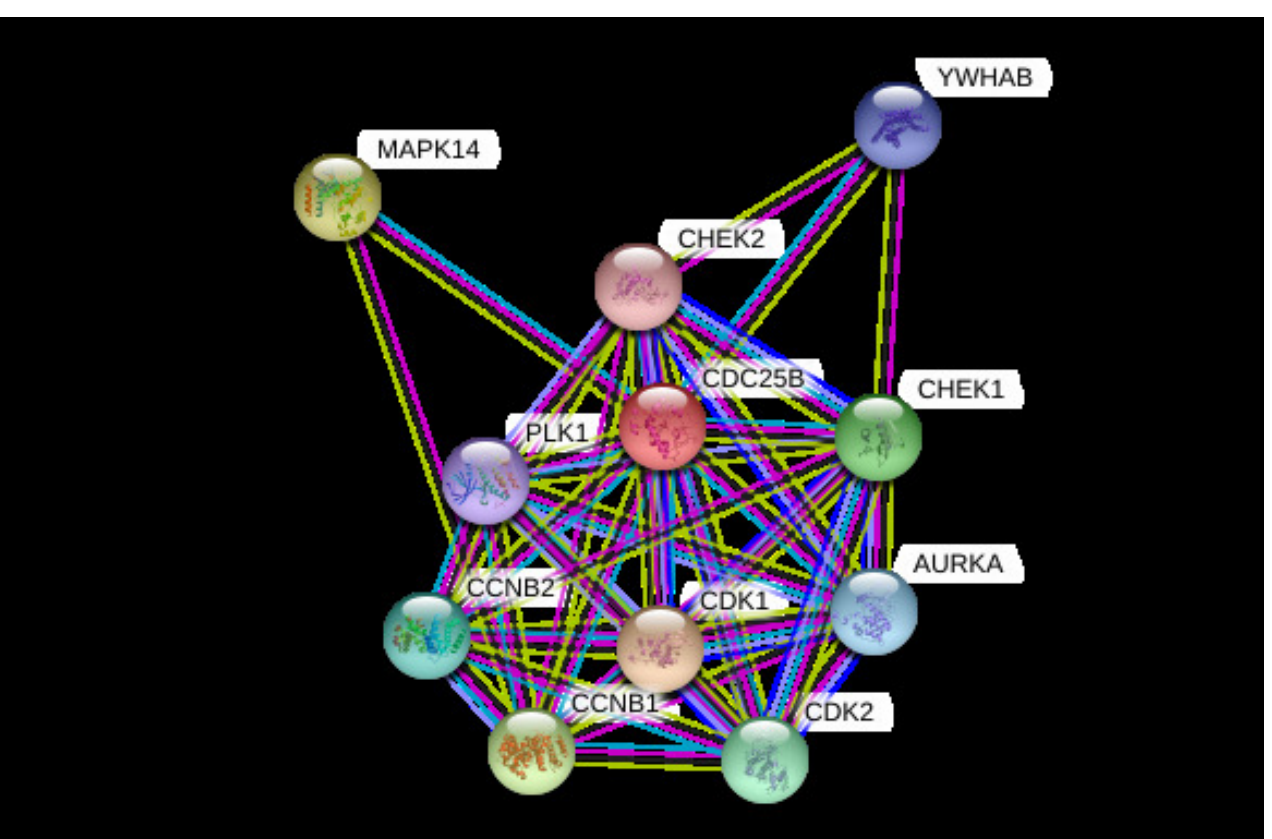
FIGURE 8 - CDC25B protein-protein interaction network. Network nodes represent proteins: For Review Only splice isoforms or post-translational modifications are collapsed, i.e. each node represents all the proteins produced by a single, protein-coding gene locus. Edges represent protein-protein associations: associations are meant to be specific and meaningful, i.e. proteins jointly contribute to a shared function; this does not necessarily mean they are physically binding each